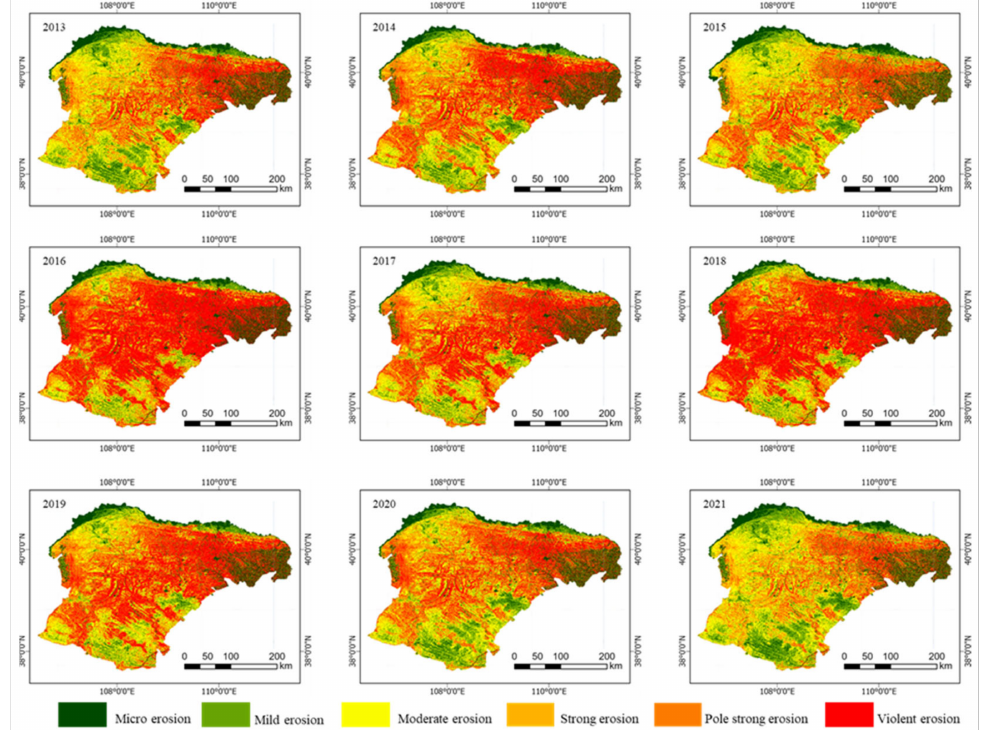
Figure 5. Soil erosion intensity map for each